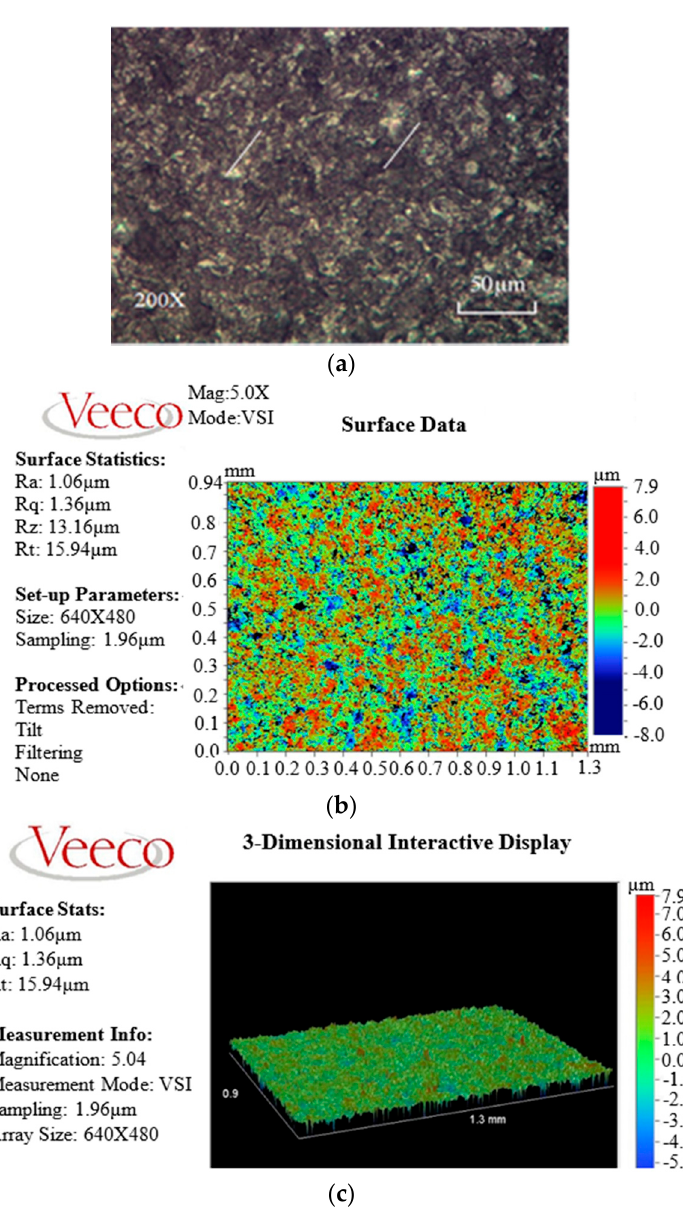
Figure 12. Initial state of sapphire substrate: ( a ) surface micrograph; ( b ) 2D surface morphology; and ( c ) 3D surface morphology.